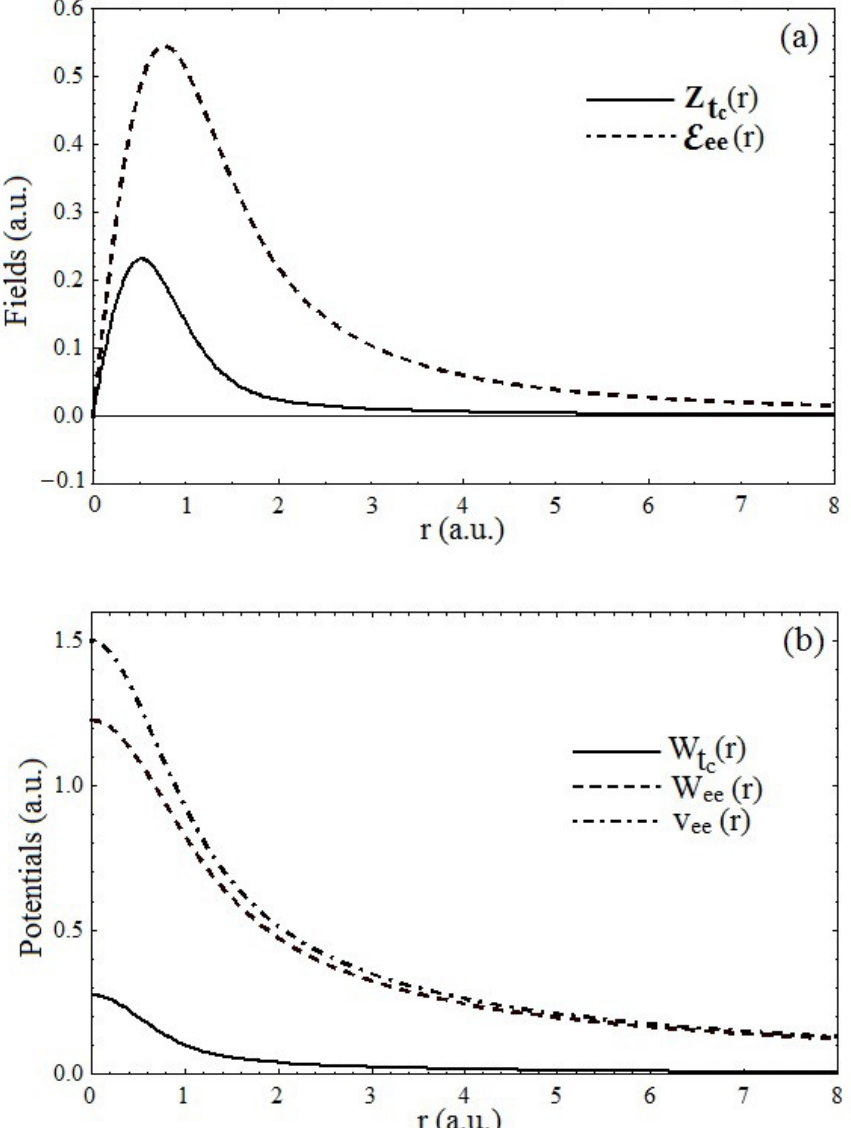
Figure 1. Fields and potentials of the model noninteracting fermions in their ground state for the mapping from a quantum dot in a magnetic field also in a ground state: ( a ) the electron-interaction (Pauli–Coulomb) E ee ( r ) and Correlation–Kinetic Z t potential v ee ( r ) and its Pauli–Coulomb W ee ( r ) and Correlation–Kinetic W t